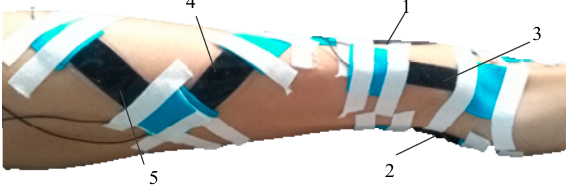
Figure 7. Measurements of the coupling between the component motions. Table 1. Kinematically-coupled output voltages of the five DESs in Figure 7.